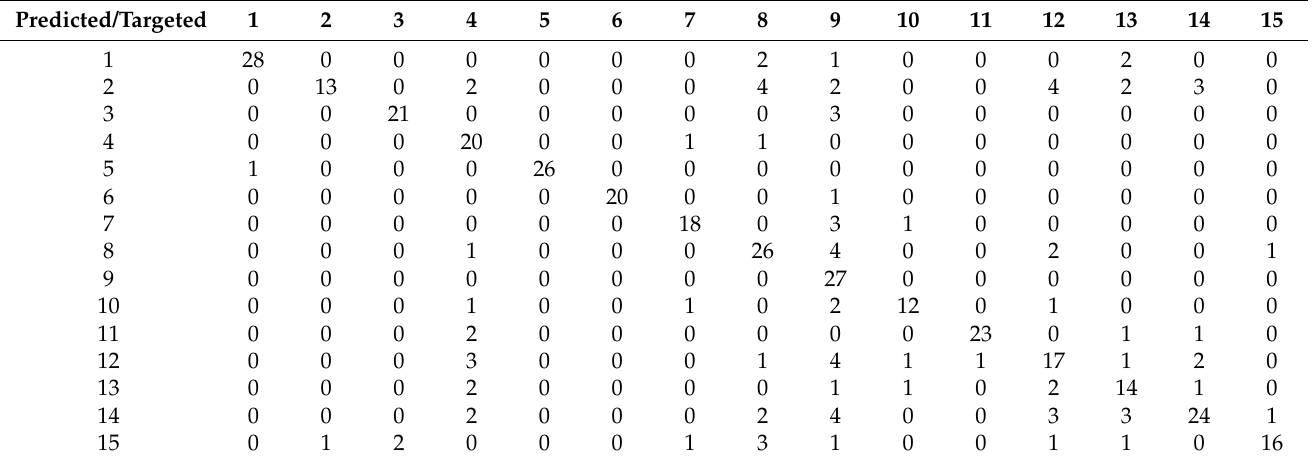
Table 2. The confusion matrix for UCF15 dataset (modified UCF101